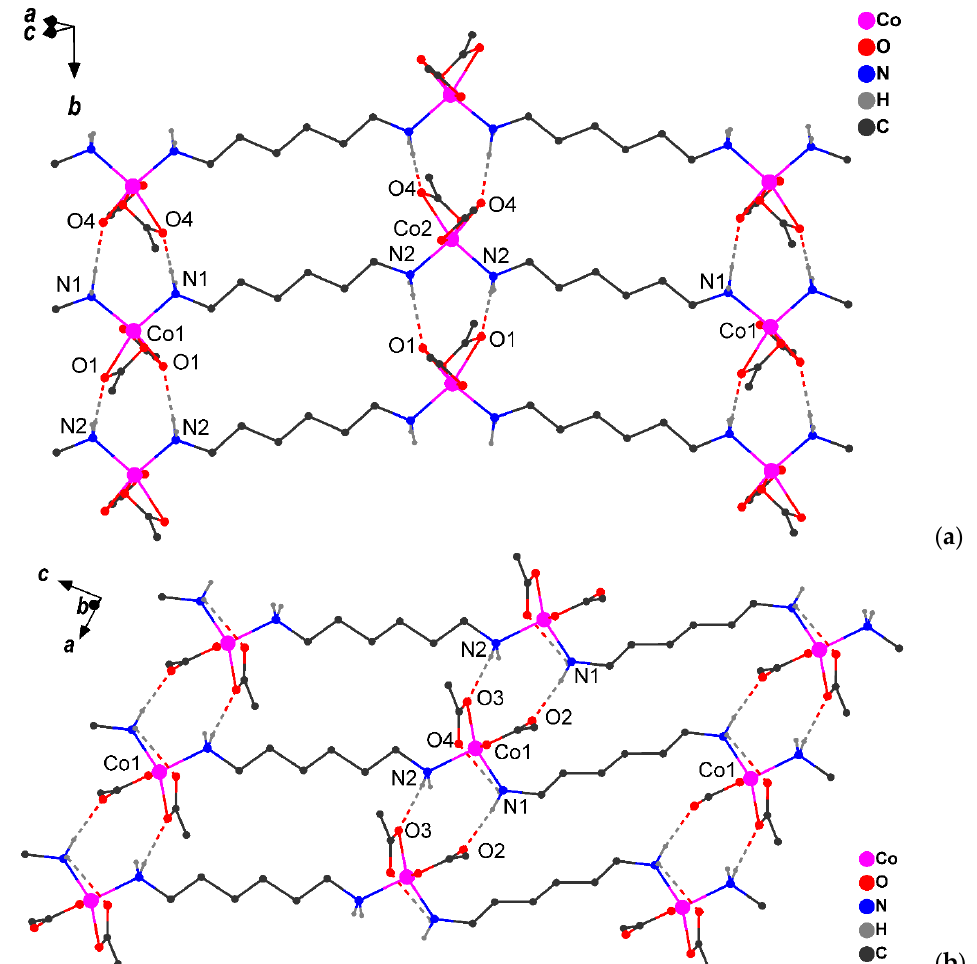
Figure 3. Fragments of crystal packing in α - 1 ( a ) and γ - 1 ( b ) (H atoms bonded to carbons atoms and CH 3 -groups are omitted, H-bonds are shown by dotted line).